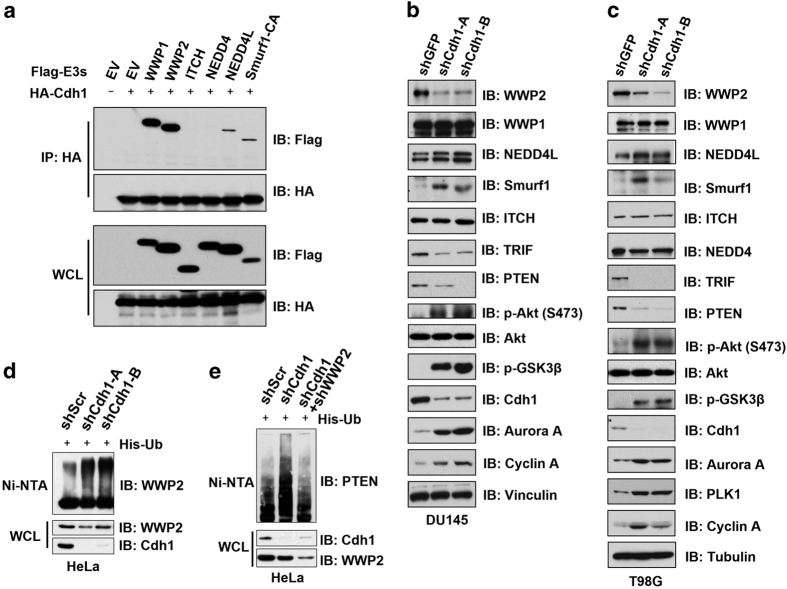
Cdh1 negatively regulates the E3 ligase function of WWP2. (a) Immunoblot (IB) analysis of whole-cell lysates (WCL) and immunoprecipitates (IP) derived from 293 T cells transfected with various Flag-tagged E3 ligase constructs together with HA-Cdh1. Thirty-six hours post transfection, the cells were pretreated with 10 μM MG132 for 10 h before collecting. The enzymatically inactive Smurf1/CA mutant was used to enhance Smurf1 expression to match protein abundance comparable to other NEDD4 family proteins. (b, c) IB analysis of WCL derived from DU145 (b) or T98G (c) cells infected with the indicated lentiviral shRNA constructs. The infected cells were selected with 1 μg ml−1 puromycin for 72 h to eliminate the noninfected cells before collecting for IB analysis. (d, e) IB analysis of WCL and subsequent Ni-NTA pull-down in 6 M guanidine-HCl-containing buffer derived from HeLa cells infected with the indicated shRNA constructs. The infected cells were selected with 1 μg ml−1 puromycin for 72 h to eliminate the noninfected cells before collecting. The cells were pretreated with 10 μM MG132 for 10 h before collecting. shRNA, short hairpin RNA.